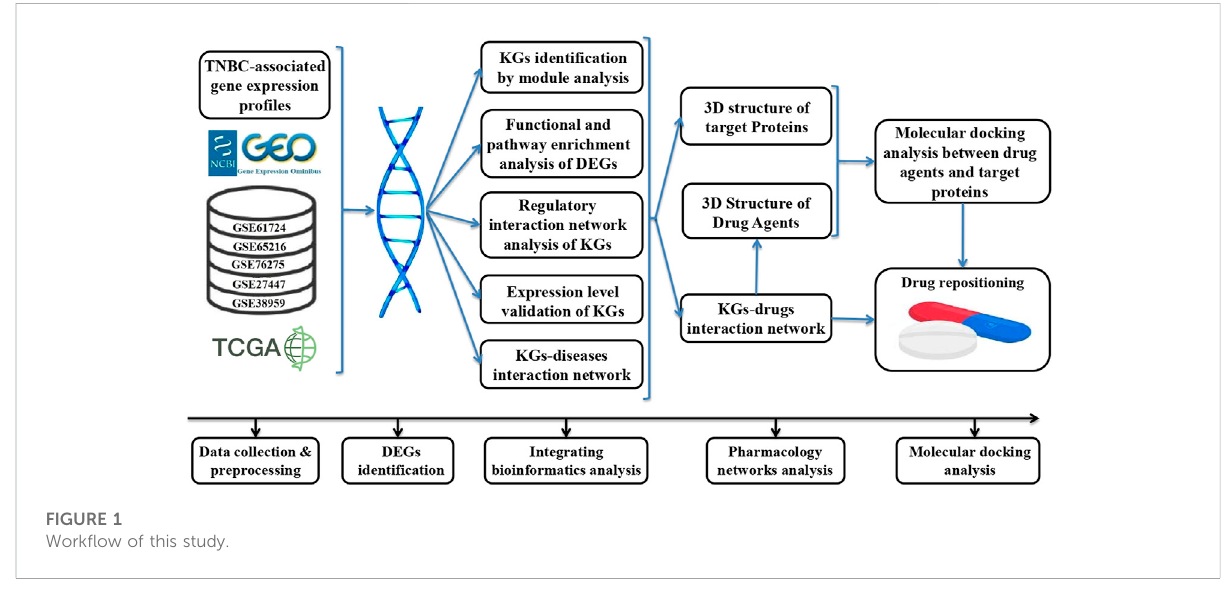
FIGURE 1 Work fl ow of this study.